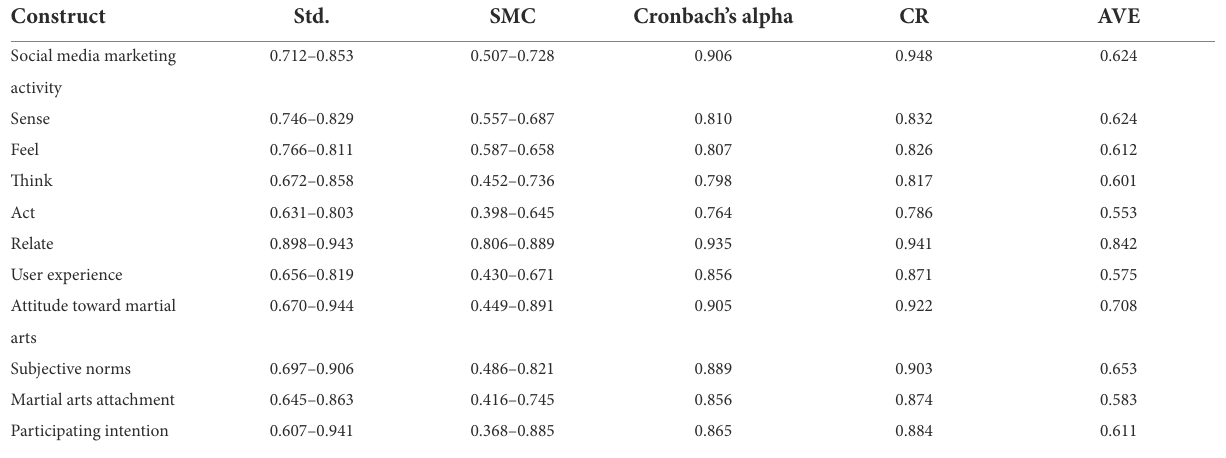
TABLE 3 Confirmatory factor analysis.